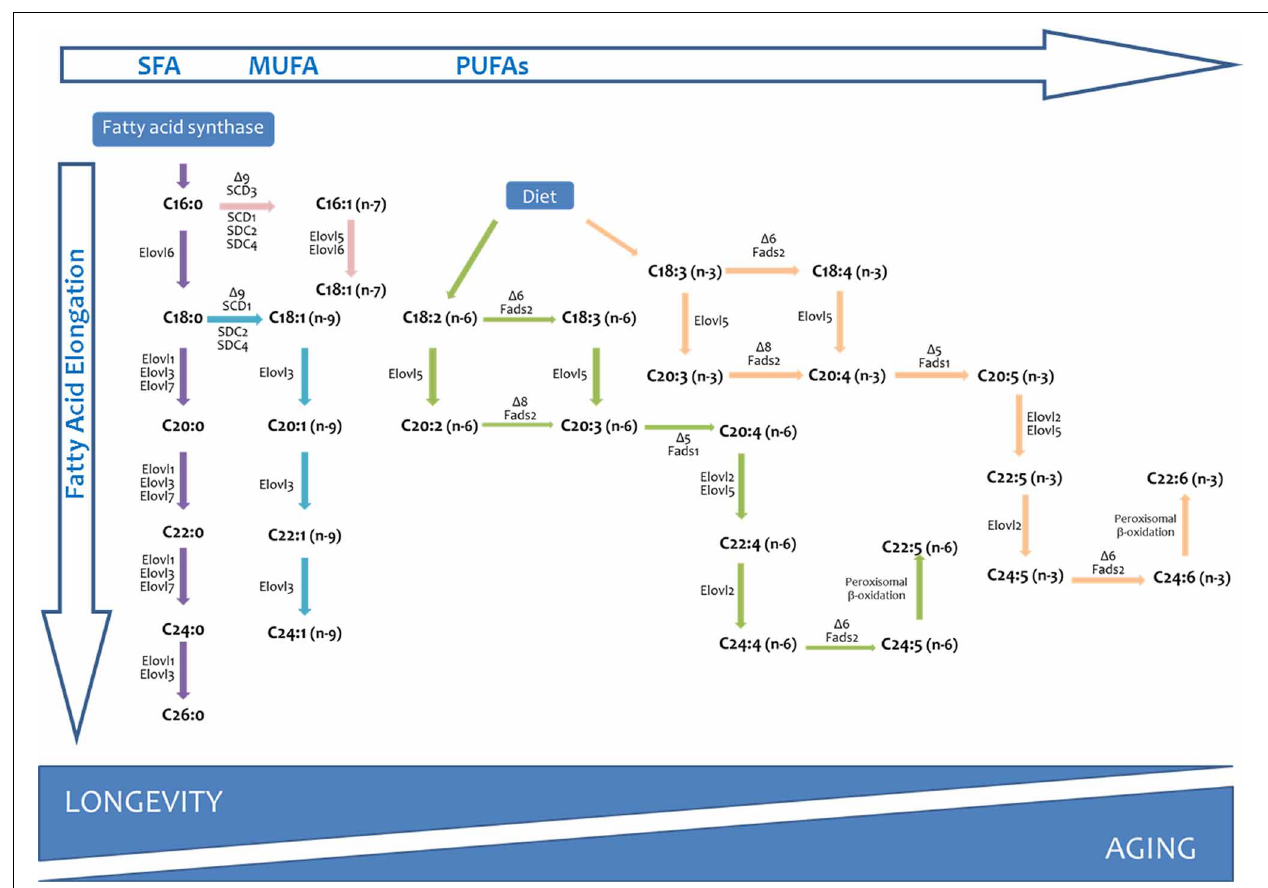
FIGURE 2 | Long chain and very long-chain fatty acid biosynthesis in vertebrates. The long chain saturated fatty acids and unsaturated fatty acids of the n -7 and n -9 series can be synthesized from palmitic acid (C16:0) produced by the fatty acid synthase (FAS). Long-chain